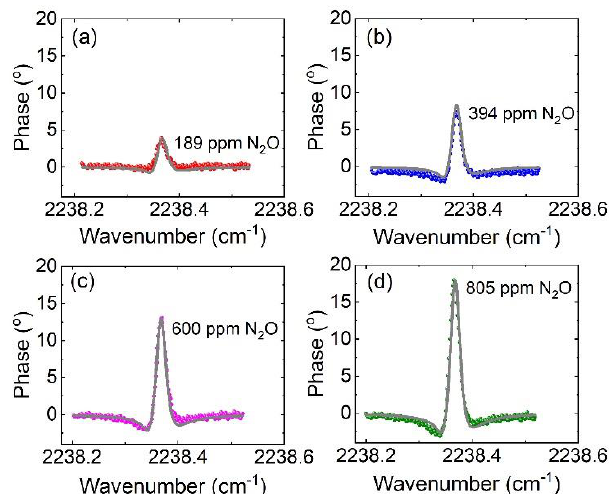
Figure 3. Representative HPSDS phase signals measured at 200 Torr for different N 2 O concentrations (symbol, experiment; line, simulation): ( a ) 189 ppm, ( b ) 394 ppm, ( c ) 600 ppm, and ( d ) 805 ppm.